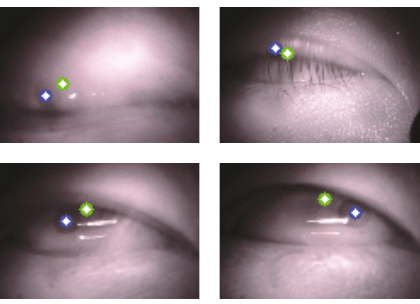
Figure 10: Failure samples.